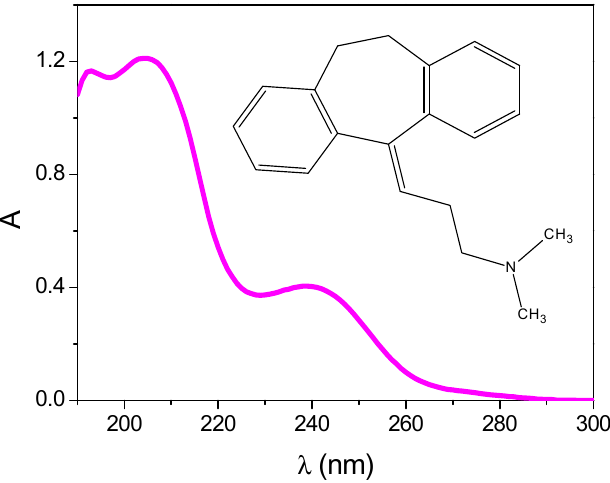
Figure 1. Absorption spectrum of amitriptyline hydrochloride (AMI) aqueous solution (0.0300 mmol/L). Inset represents structural formula of AMI. Table 1. Properties of AMI. Therapeutic